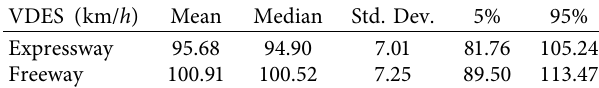
Table 11: Desired speeds per roadway type. VDES ( km/ h ) Mean Median